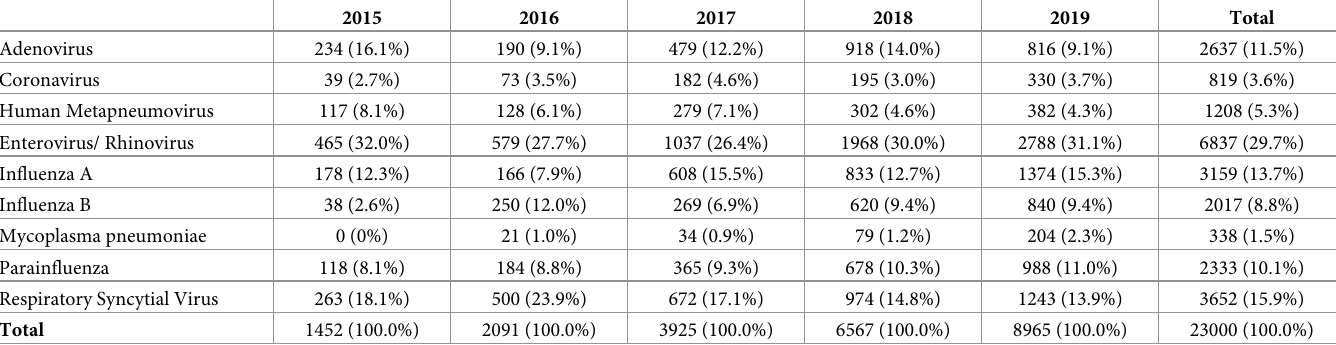
Table 2. Prevalence of respiratory pathogens detected from year 2015 to